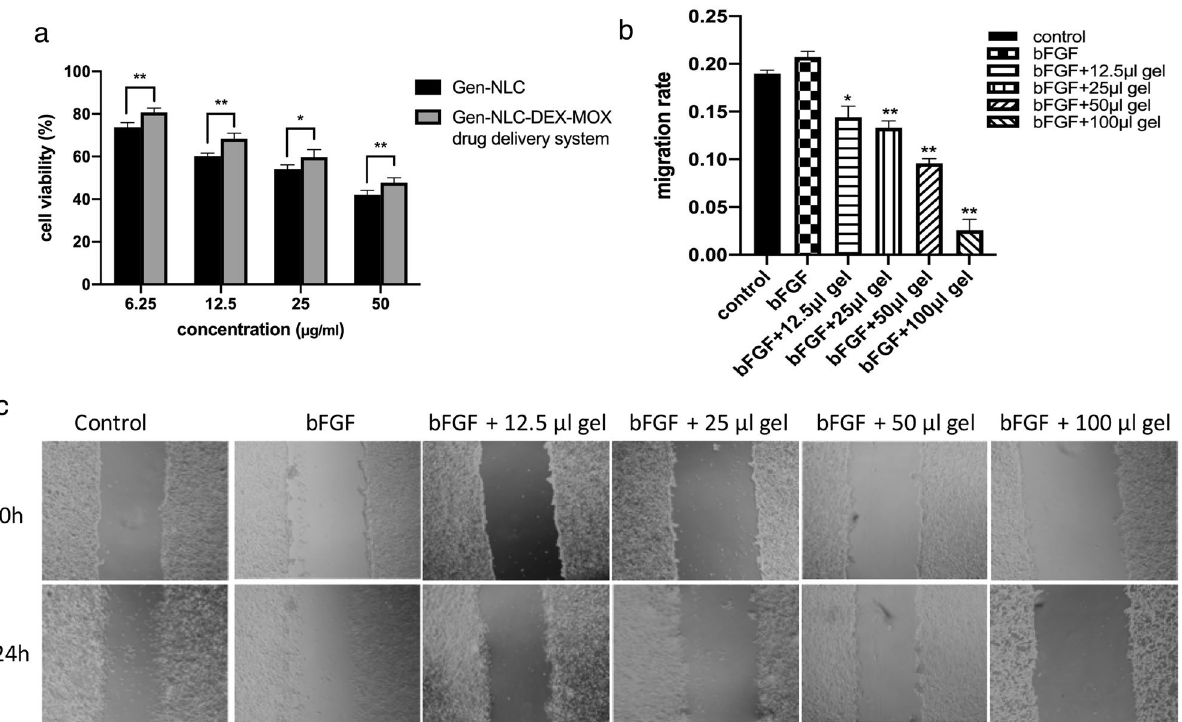
Figure 3. Effects of GenNLCs and GenNLC-Dex-Mox drug delivery system on cell viability and cell migration of LECs. ( a ) GenNLCs and the multi-drug delivery system could inhibit the proliferation of lens epithelial cells in a dose-dependent manner (6.25, 12.5, 25, 50 μg/mL of Genistein concentration in culture medium). However, compared with the results of the groups treated with GenNLCs (73.74 – 42.09%), the cell viabilities in the hydrogel groups were significantly higher (80.75 – 47.78%) ( P < 0.05). Results are shown as mean ± SD (n = 4). ( b , c ) Effects of GenNLC-Dex-Mox treatment on SRA cells migration, scale bar = 100 μm. The wounded area of SRA cells was quantified by ImageJ software. The LECs in the bFGF group had the highest migration rate (20.75%), while, the hydrogel inhibited the cell migration in a dose dependent manner. Results are shown as mean ± SD (n = 3). *P < 0.05, ** P < 0.01, *** P <